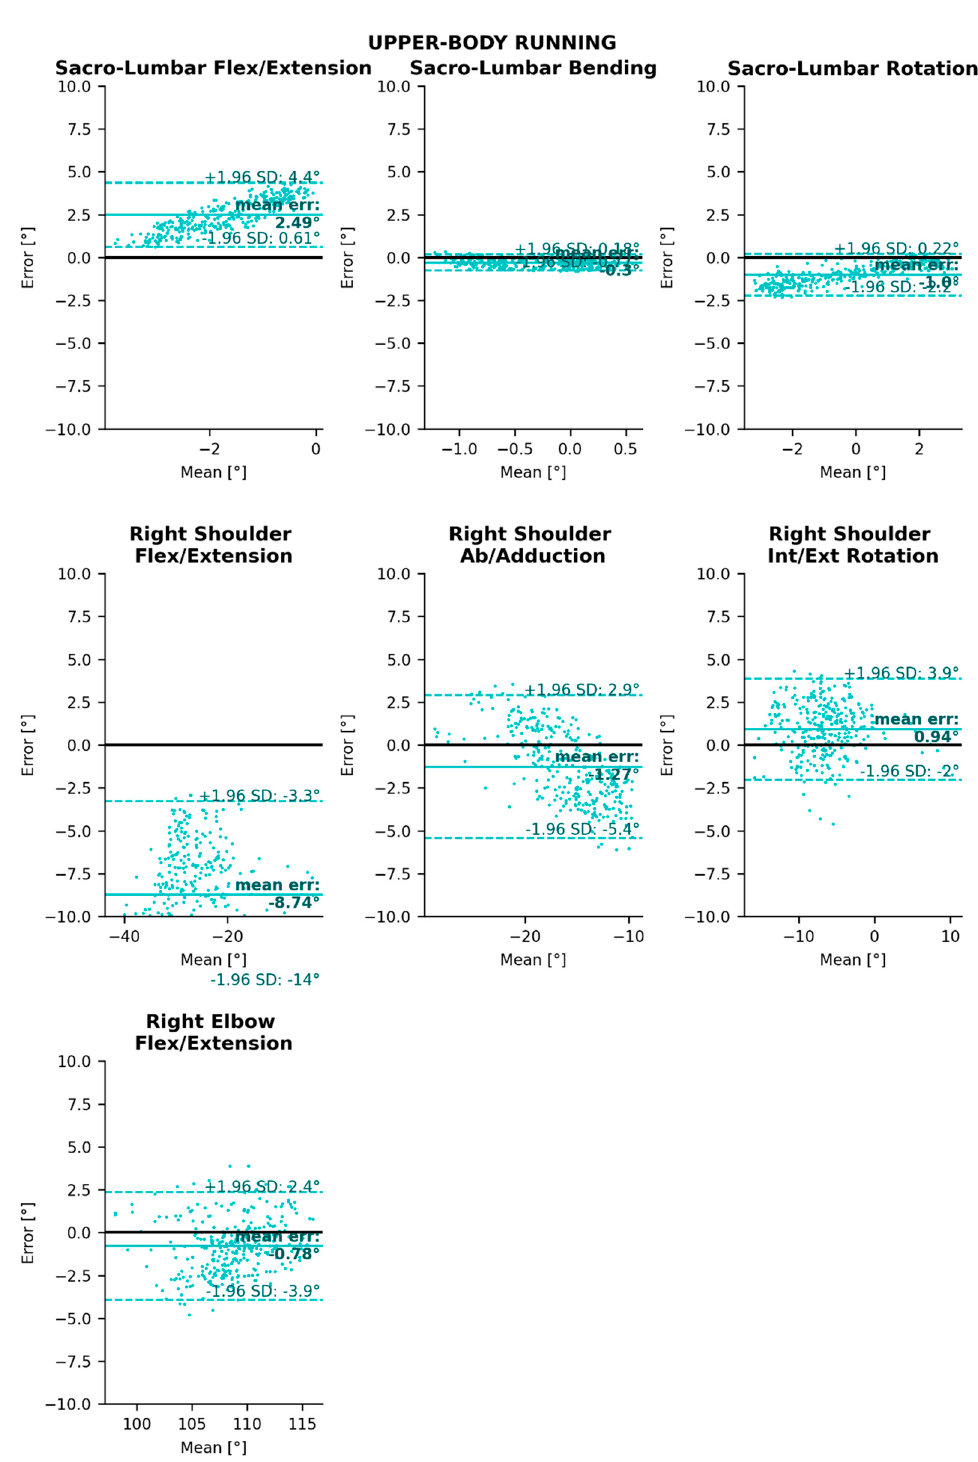
Figure A6. Bland–Altman analysis of sacro-lumbar and upper-body joint angle errors for the running task. Mean bias is represented as a horizontal solid, bold line, and 95% limits of agreement are represented as dotted lines.